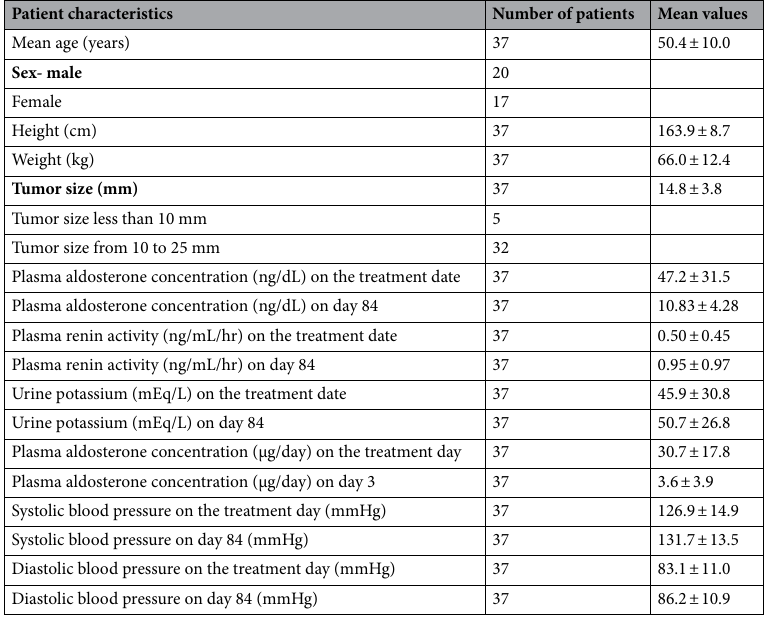
Table 1. Patient backgrounds and tumor